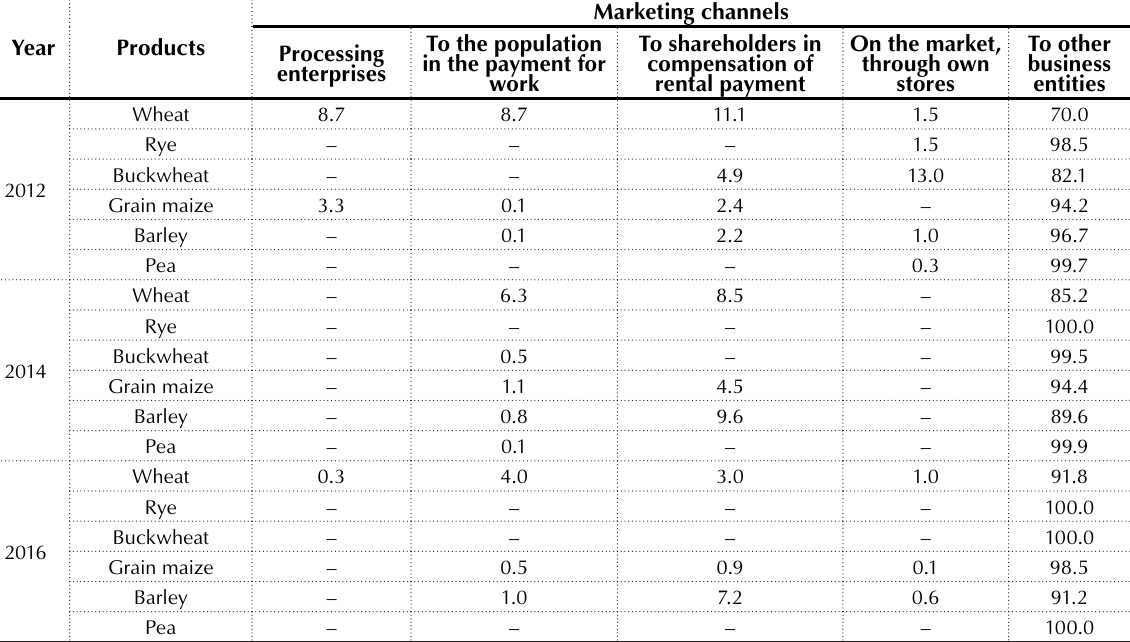
Source: Compiled based on Statistical Yearbook of